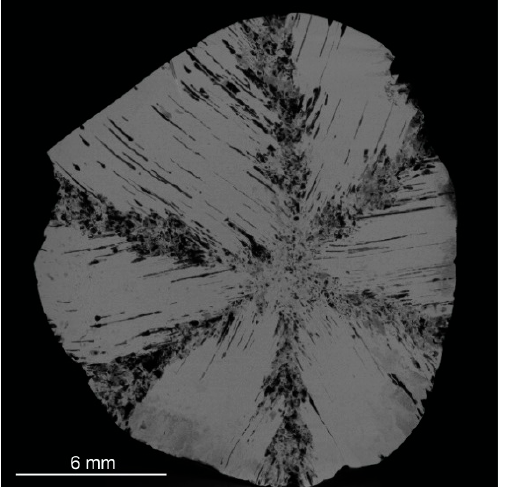
Figure 12. X-ray computed tomography image showing the high porosity (in black) of a trapiche ruby from Luc Yen, North Vietnam [57]. The porosity corresponds to 0.6% of the ruby volume and is developed in the sector boundaries. Photo: Christophe Morlot.